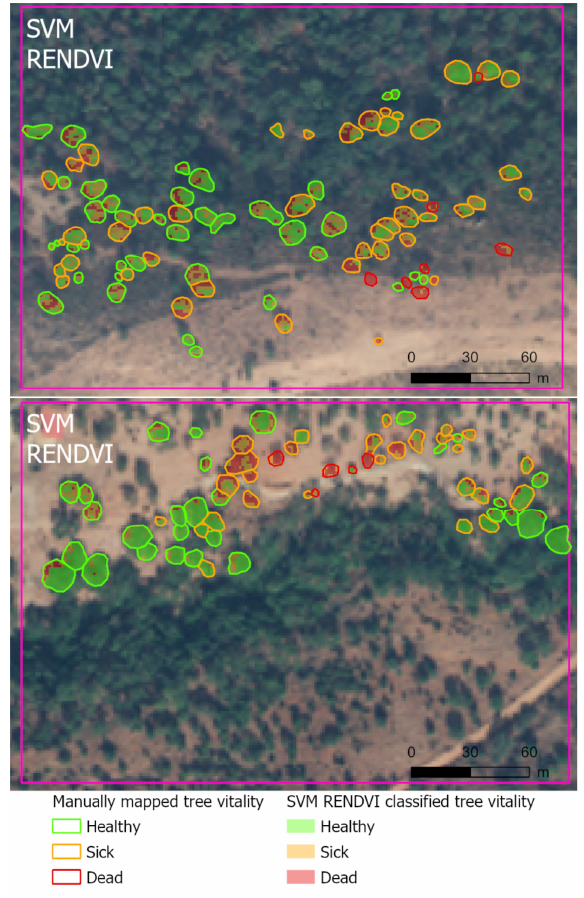
Figure 3. Comparison between the raster classified with RENDVI and Support Vector Machine and the mapped ground truth. Shown are area 4 (top) and area 11 (bottom) in Figure